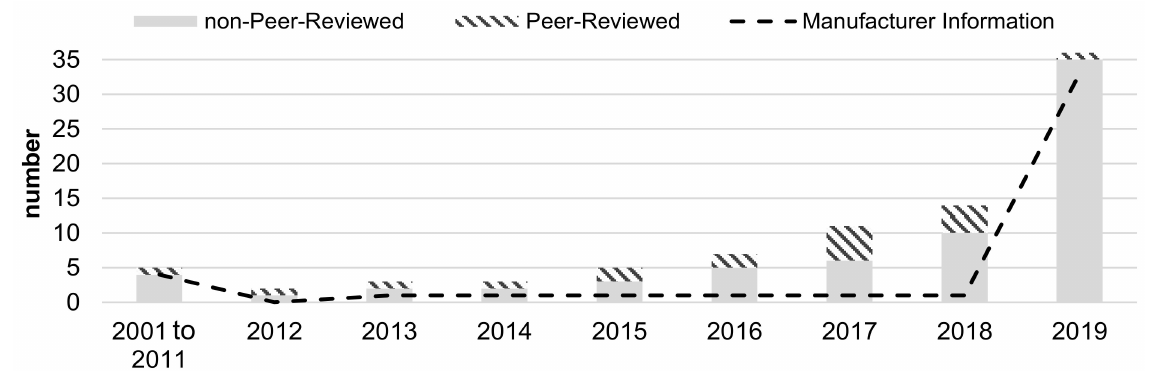
Figure 3. Number of reviewed literature sources by type, assigned to peer-reviewed or non-peer-reviewed papers over the years 2001–2019